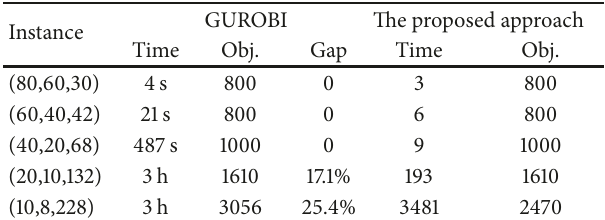
Table 3: Results and comparisons for different approaches.